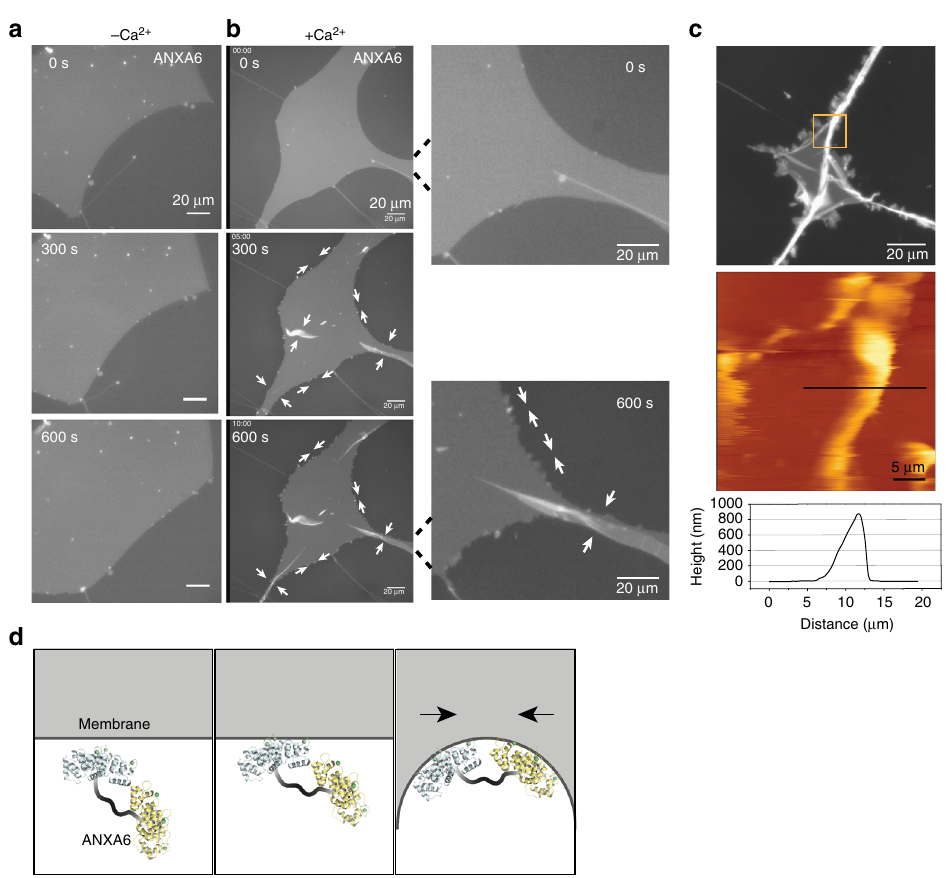
Fig. 5 ANXA6 triggers in-plane constriction of membrane edges and shrinkage of supported membrane islands. a Sequential images before and after addition of ANXA6 protein to a membrane patch stained with DiD in the absence of Ca 2+ or b in the presence of Ca 2+ . Note that ANXA6 induces in-plane folding of membrane edges (lower panel, magni fi ed image) as well as larger out-of-plane folds (white arrows). c Fluorescence and matching AFM images of membrane patch after completed ANXA6 folding. Lower panel: corresponding AFM-topography graph. d Model for ANXA6-triggered local membrane constriction by cross bridging of adjacent membrane via the two core